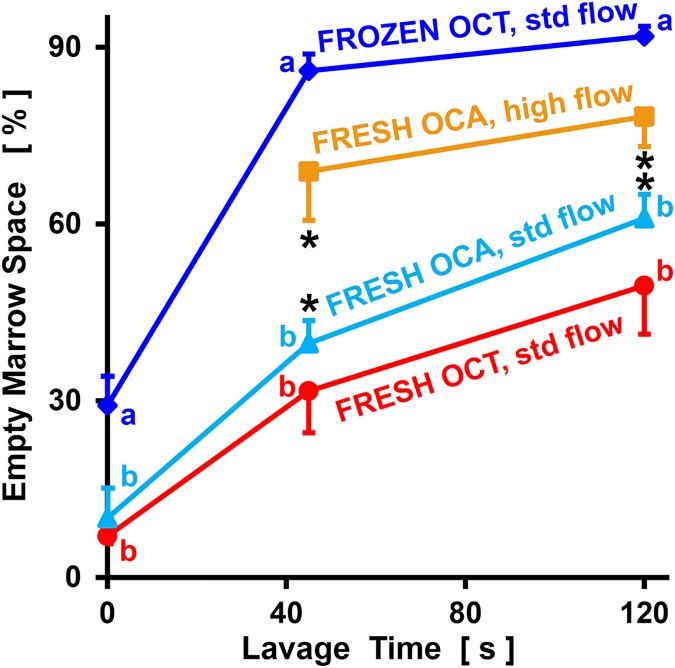
Percentage of empty marrow space of OCs after different storage and lavage treatments.Samples were OCT/FROZEN, OCT/FRESH, or OCA/FRESH, and subjected to standard (std) or high flow lavage for 0–120 s. Data are shown as mean ± SE, n = 3–7. Different letters (a, b) indicate experimental groups that are significantly different (p<0.05). * indicates the paired OCA/FRESH at standard flow and high flow groups are significantly different (p<0.05).